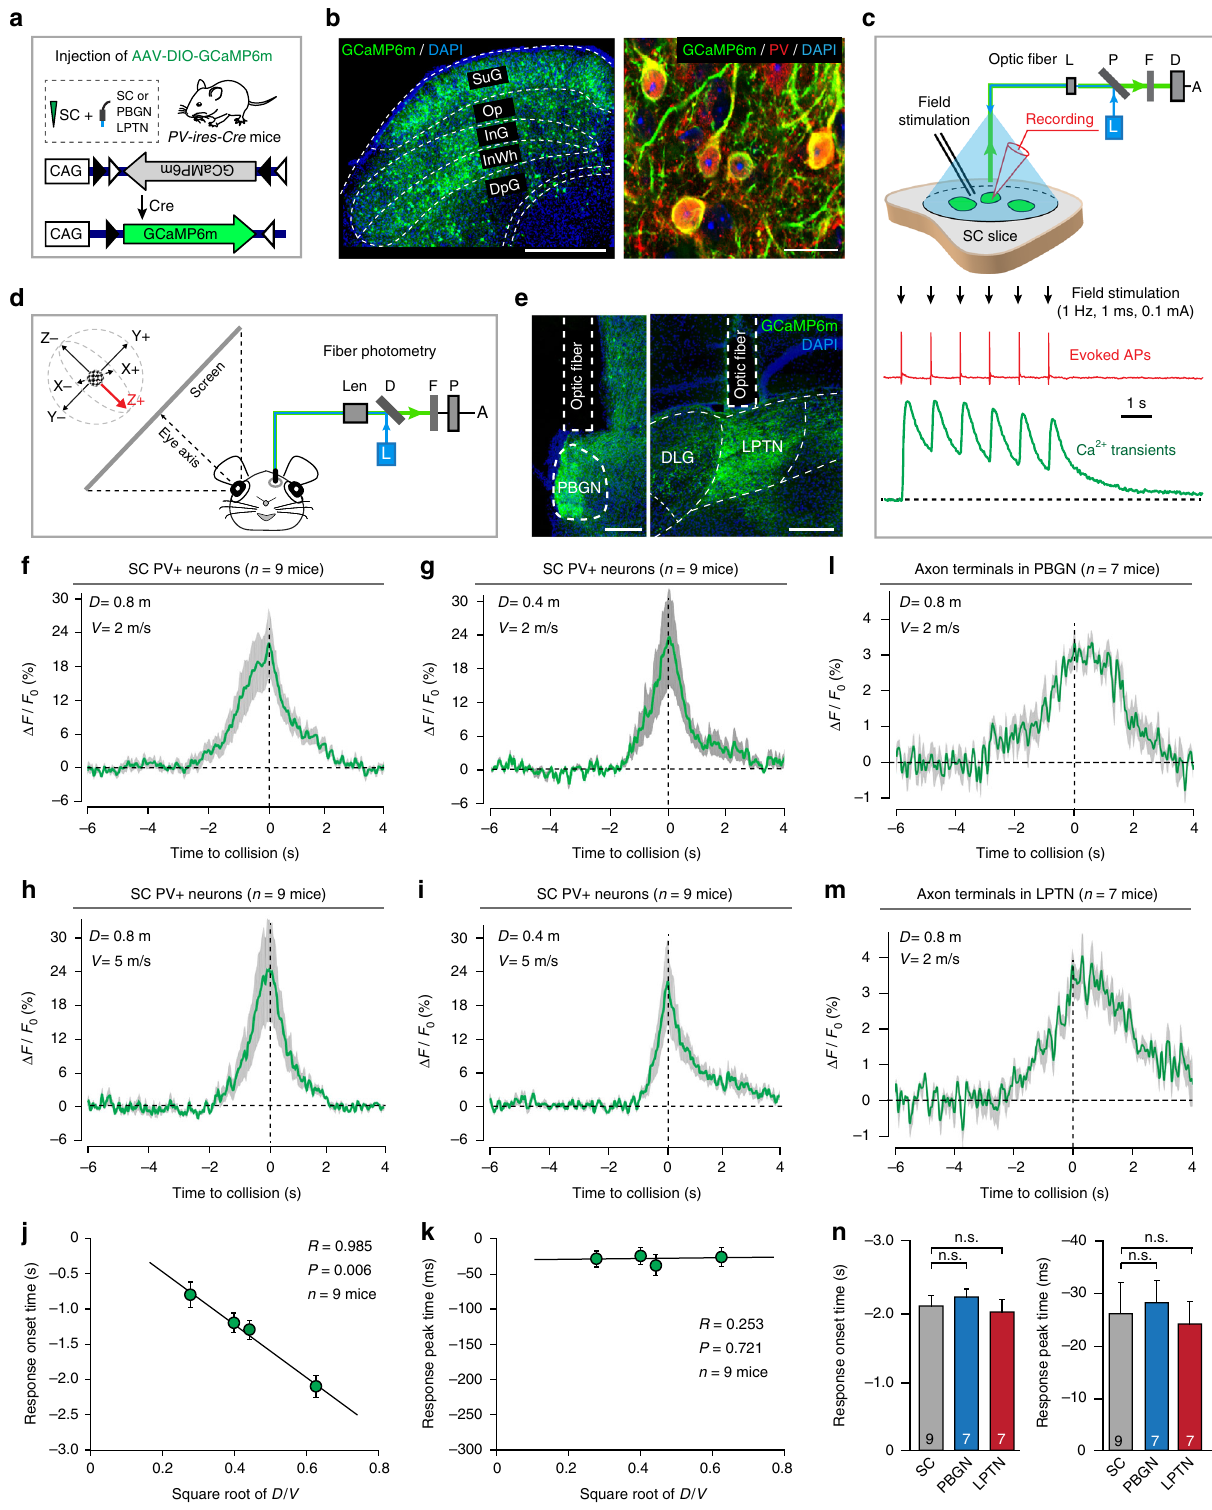
(EGFP: Fig. 6a, b and Supplementary Fig. 7c, d; GCaMP6m: Fig. 6c, d and Supplementary Fig. 7e, f; ChR2-mCherry: Fig. 7a, b and Supplementary Fig. 7g, h; EGFP-2A-TeNT: Fig. 8a, b and Supplementary Fig. 7i, j) into the PBGN (200 nl) and LPTN (400 nl) of vGlut2-ires-Cre mice with a nano-liter